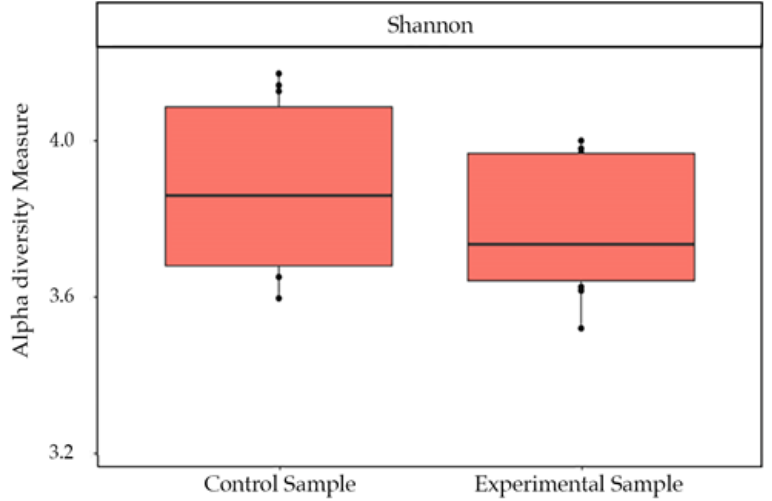
Figure 2. Shannon diversity calculated on raw data. Box plots show the indices based on samples bacterial communities in control and experimental samples. No significant differences were recorded.